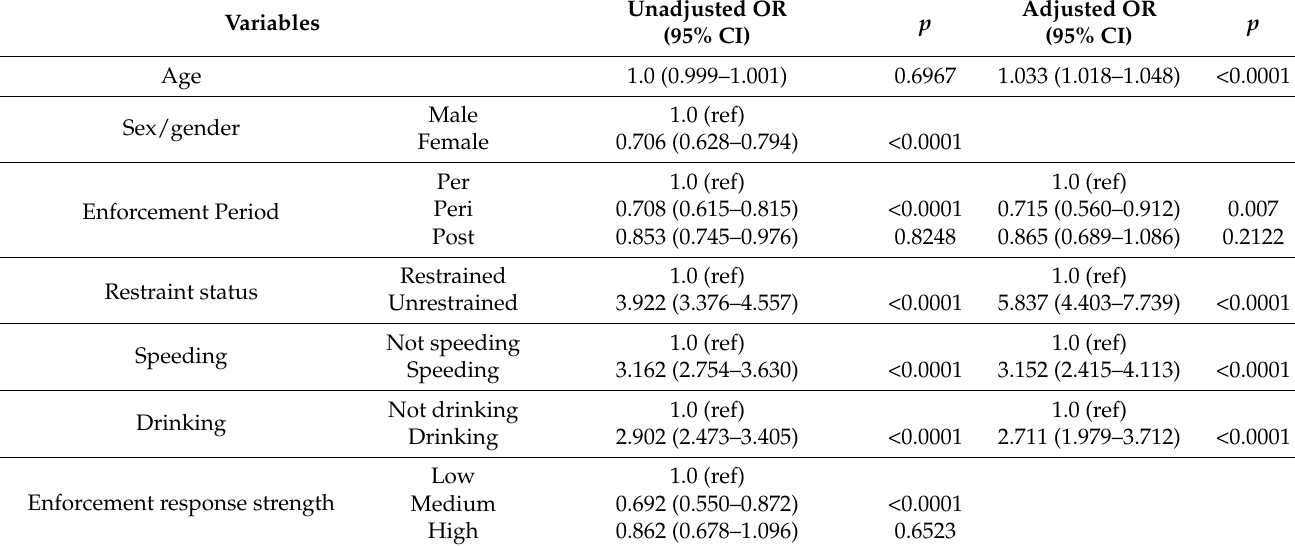
Table 3. Unadjusted and Multivariable Adjusted Analysis of Fatal Motor Vehicle Crashes on a U.S. Roadway, Fatality Analysis Reporting System (FARS),